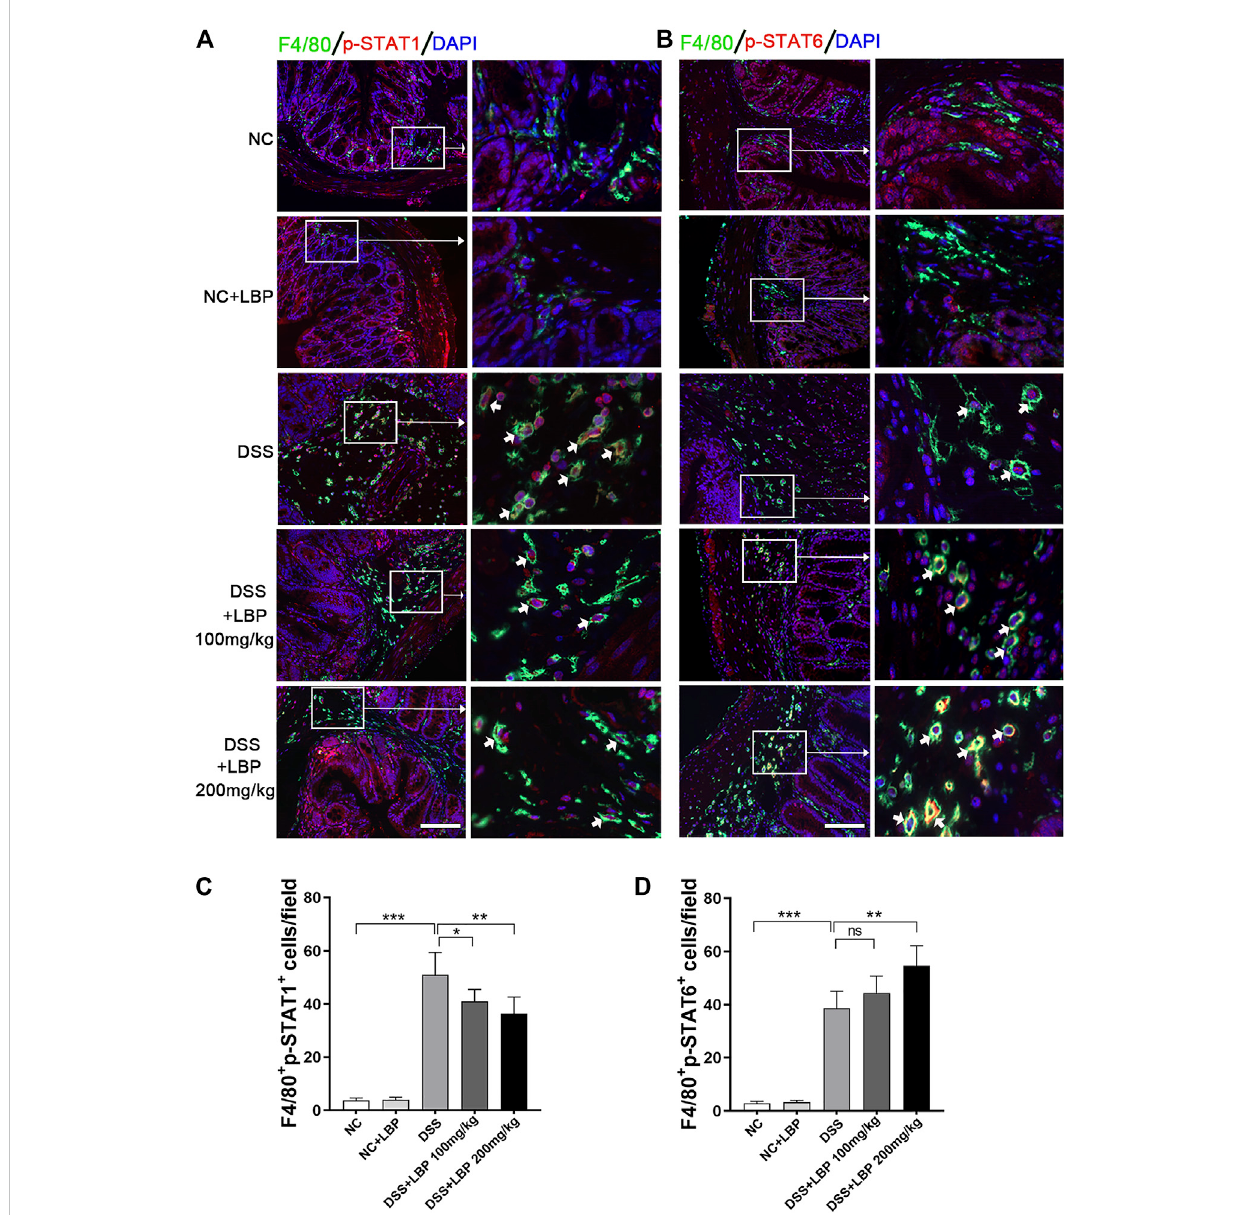
FIGURE 8 LBP regulates the STAT1 and STAT6 pathways in the colon tissue of mice DSS- induced. (A) Representative immuno fl uorescence images of F4/80 (green color) andp-STAT1(redcolor) incolon tissues from fi vegroups ofmice, and cell nucleuswere stainedwith DAPI(blue).Therightpanel istheinset imagefromthecorrespondingregionfromtheleftpanel. (B) Representativeimmuno fl uorescenceimagesofF4/80(greencolor)andp-STAT6(redcolor) in colon tissues from fi ve groups of mice, and cell nucleus were stained with DAPI (blue). The right panel is the inset image from the corresponding region from the left panel. (C) The number of F4/80 + p-STAT1 + cells in Figure 8A were quanti fi ed. (D) The number of F4/80 + p-STAT6 + cells in Figure 8B were quanti fi ed. Scale bar, 100 µm. Signi fi cant differences are indicated as * p < 0.05, ** p < 0.01; *** p < 0.001. Ns, no signi fi